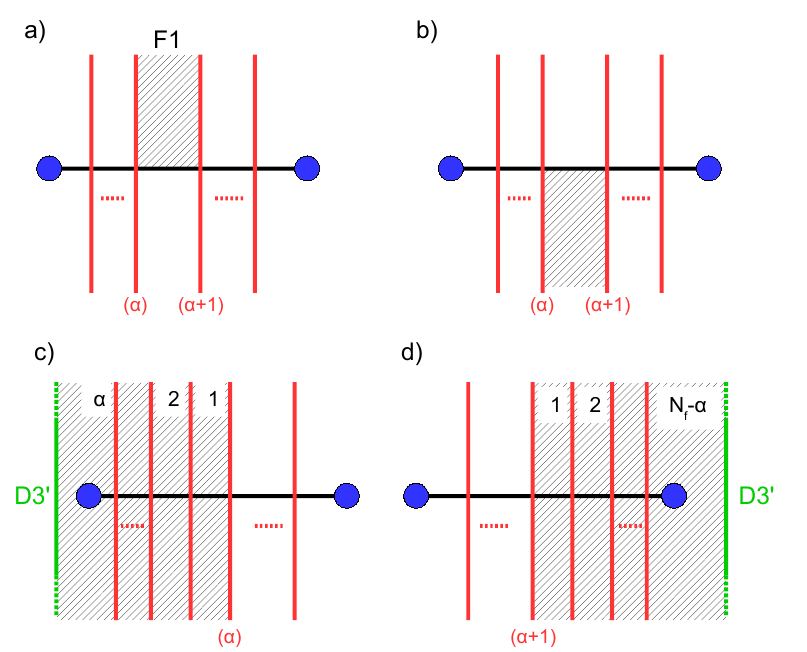
Figure 16 . Brane setups inserting the operators: a) Z (cid:11) +1 (cid:11) ; b) (cid:0) Z (cid:11) (cid:11) +1 ; c) (cid:0) Z The integers 1 ; 2 ; : : : ; (cid:11) indicate the number of superposed F1 strings in each